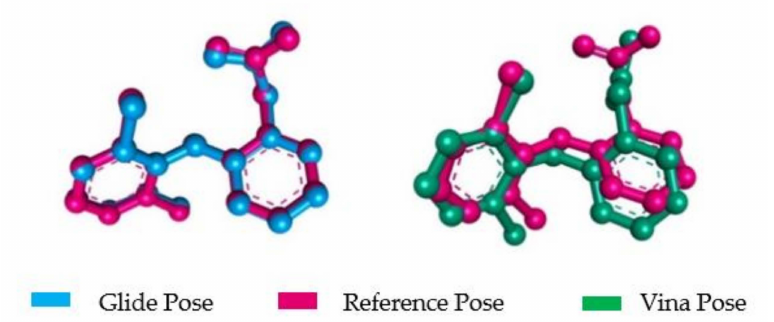
Figure 3. Superimpose of Glide and Vina generated poses over the reference